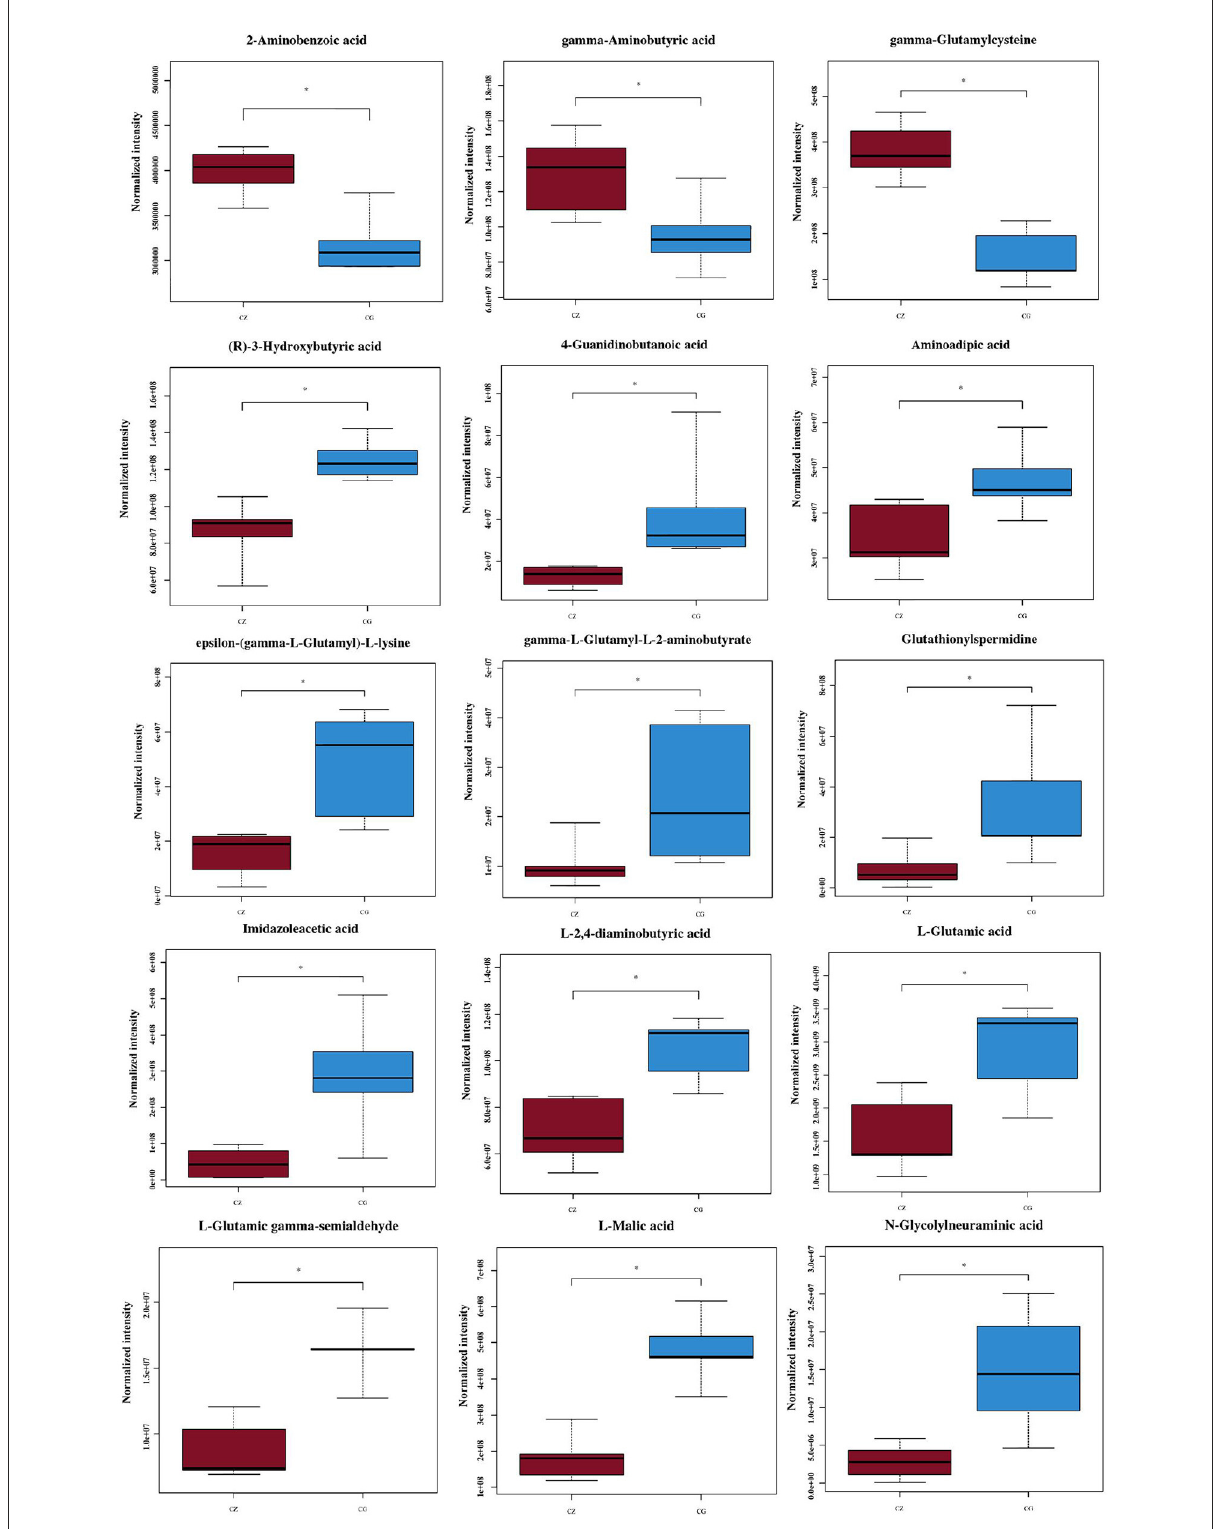
FIGURE4 Fifteen significantly different metabolites we focus of hypertension of liver-Yang hyperactivity syndrome induced by a high salt diet. CZ, normal group, CG, hypertensive group. * P < 0.05.